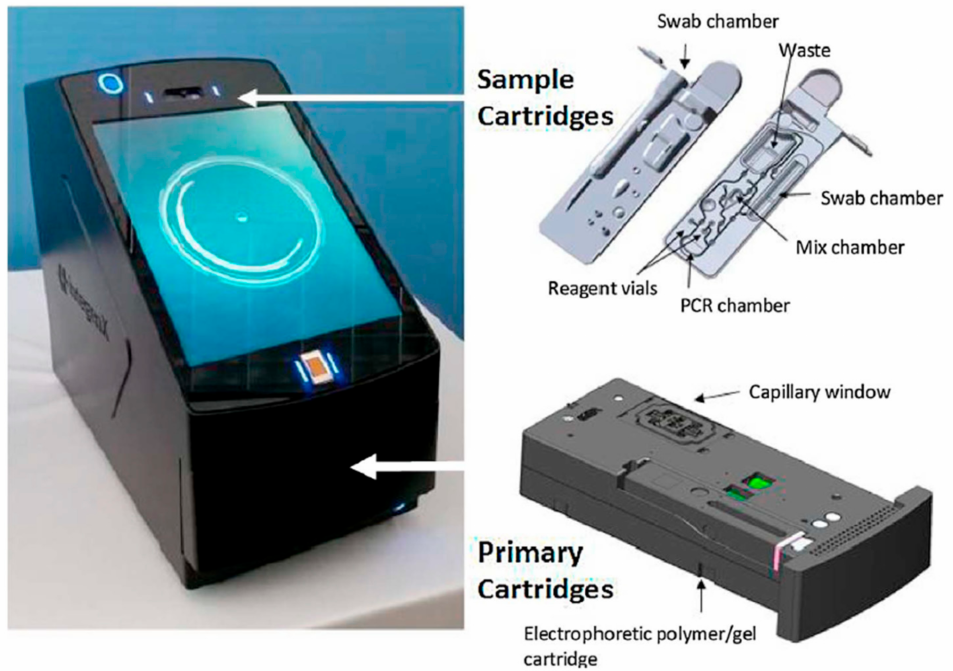
Figure 4. The RapidHIT ID system from IntegenX with a primary cartridge (a reagent cartridge that contains the necessary reagents and consumables for capillary electrophoresis) and a sample cartridge [4]. Reprinted from Forensic Science International: Genetics, Copyright (2017), with permission from